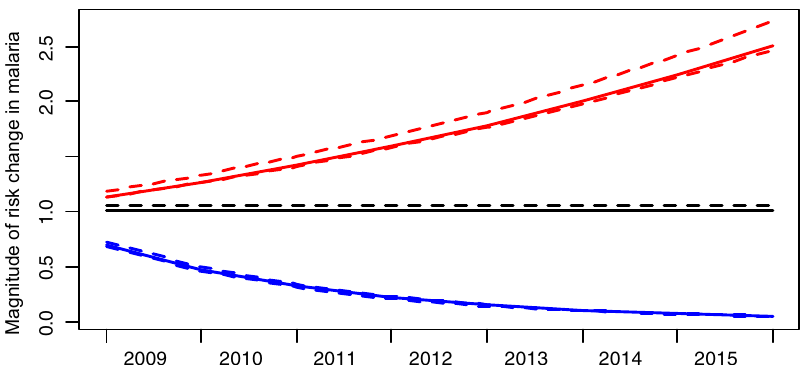
Fig. 8 Malaria risk ratio magnitude of trend-change over time in health facilities that experienced a declining, no change or increasing trends. Colours indicate different risk ratio temporal trends: blue lines — declining linear trends; red lines — increasing linear trends, black lines — constant/ no signi fi cant change in trend; dashed lines — credible intervals at 95%, and the y-axis shows the risk ratio.